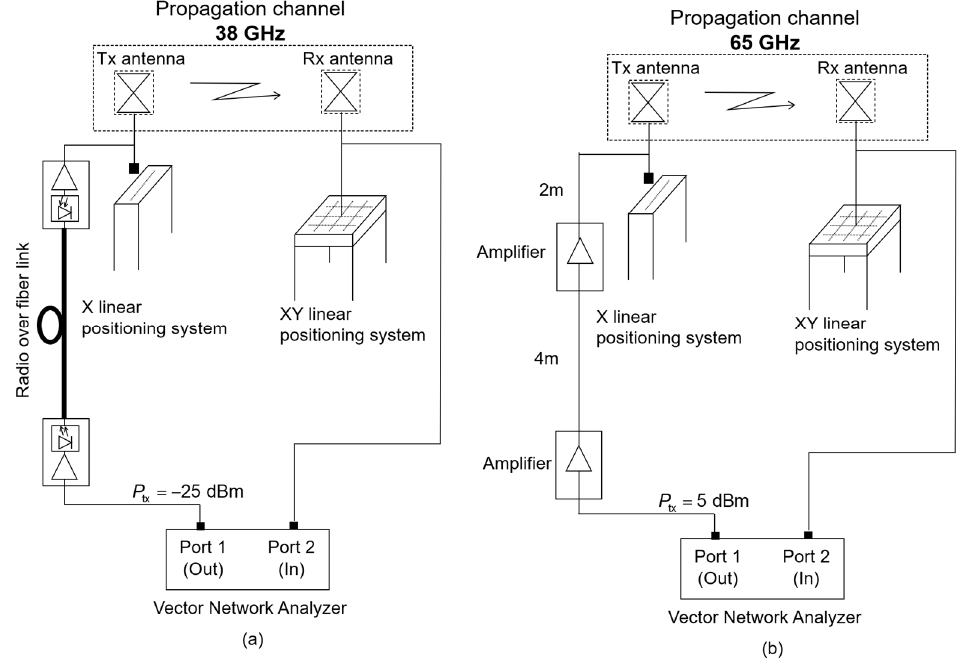
4 of 14 Table 2. Distances between transmitting and receiving antennas for each Rx position. Rx Position